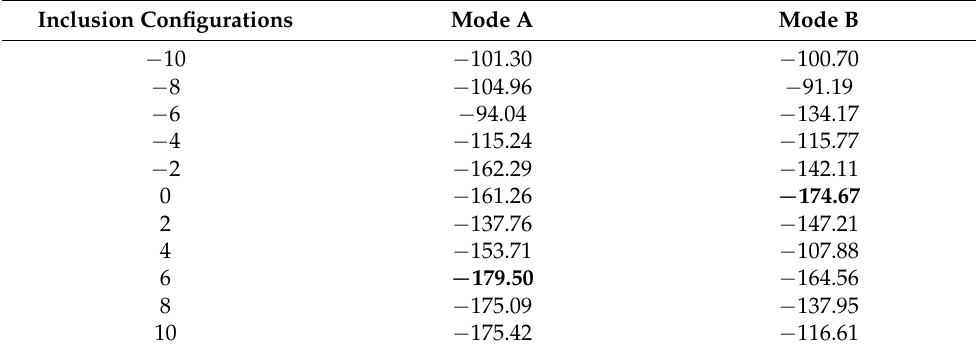
Table 1. Complexation energies (in kJ/mol) of β -CD with dexamethasone calculated in the gas phase at BLYP-D4/def2-TZVP level.